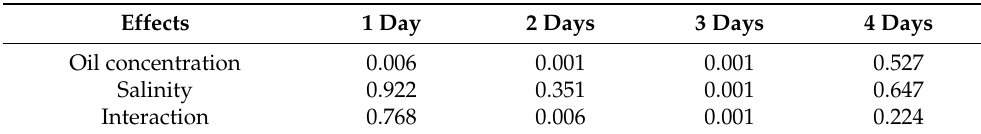
Table 3. Results of factorial ANOVA to determine the effects of treatment (control or different concentrations oil exposure) on the HR of the M. edulis under normal (25 psu) and low (15 psu) salinity during the experiment ( p